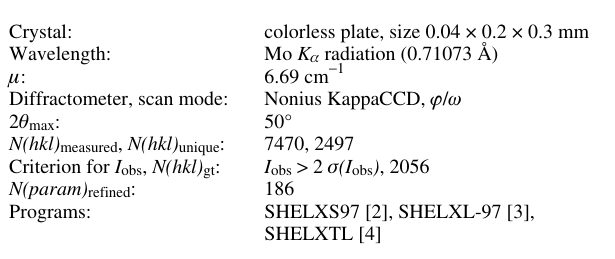
Table 1. Data collection and handling.